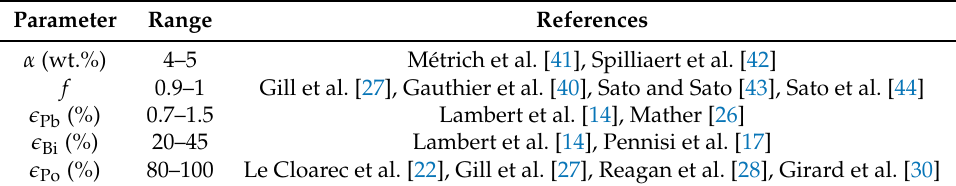
Table 2. Ranges of value regarding each parameter for the simulation.